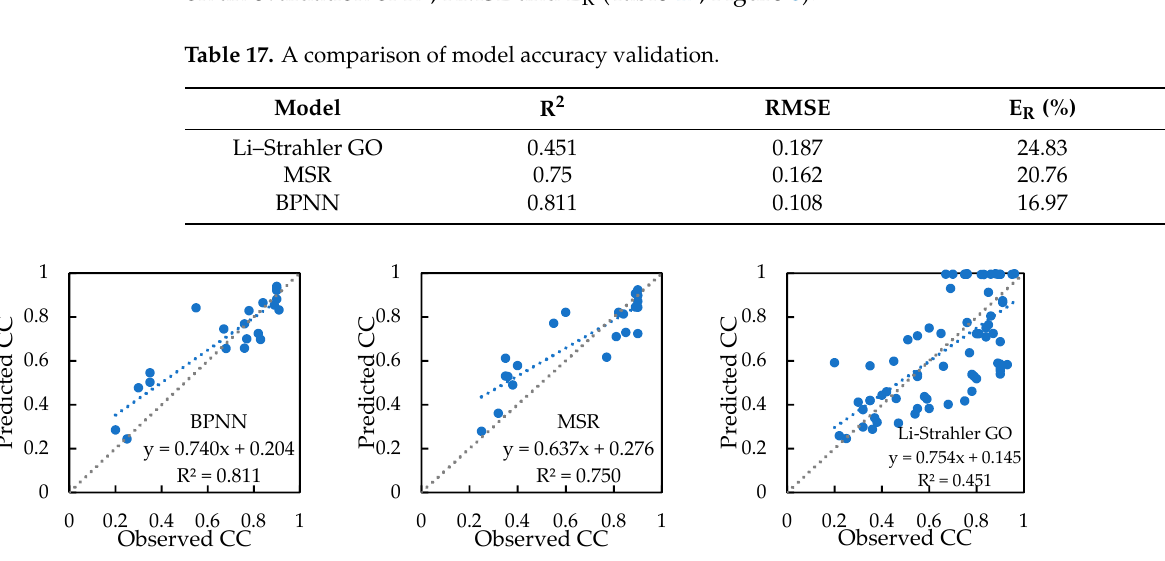
Figure 6. Scatter plot of the measured values of canopy cover and estimated values of test points.